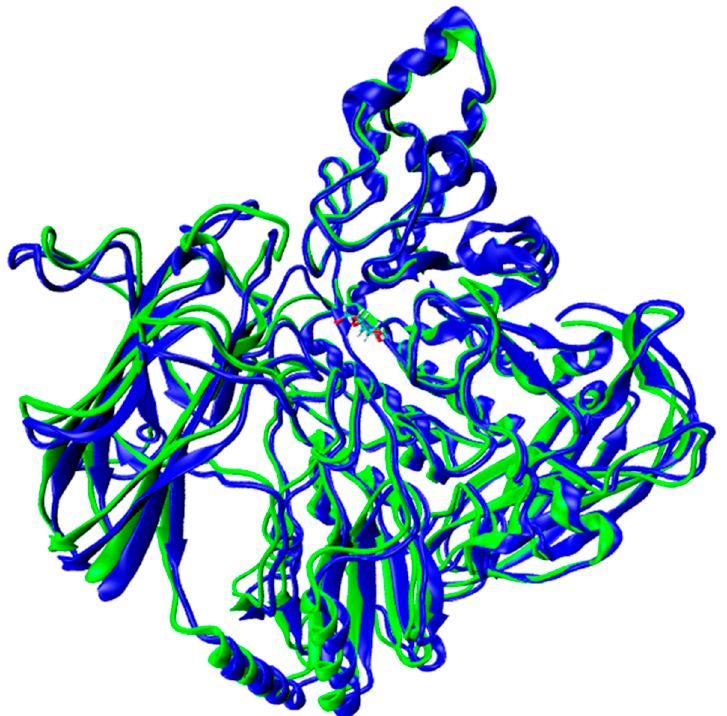
Figure 3. 3D structural overlay for template (blue) and target